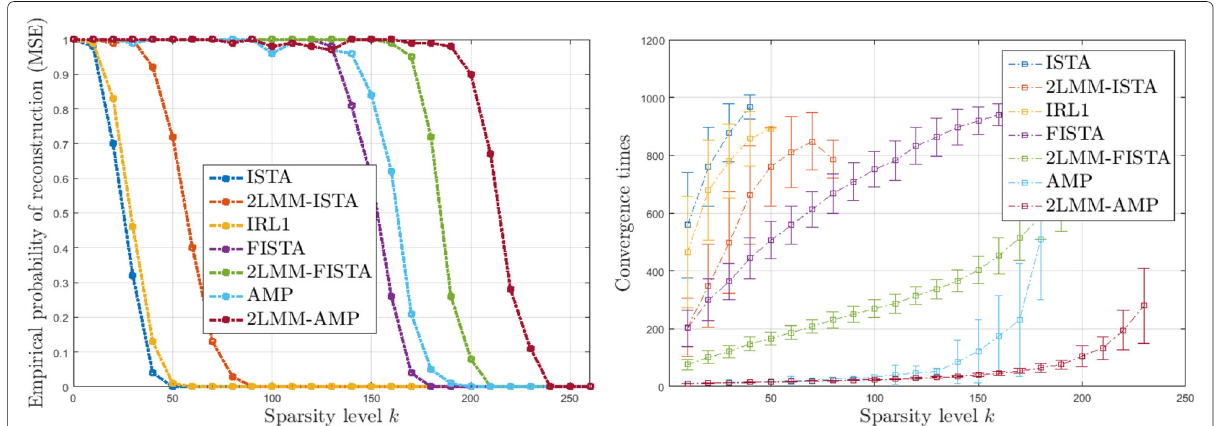
Fig. 6 Analysis of performance for L1 signals: empirical probability of successful recovery as a function of the sparsity value k with n = 512 and m = 350 sparse Bernoulli-Laplace signals (L1)